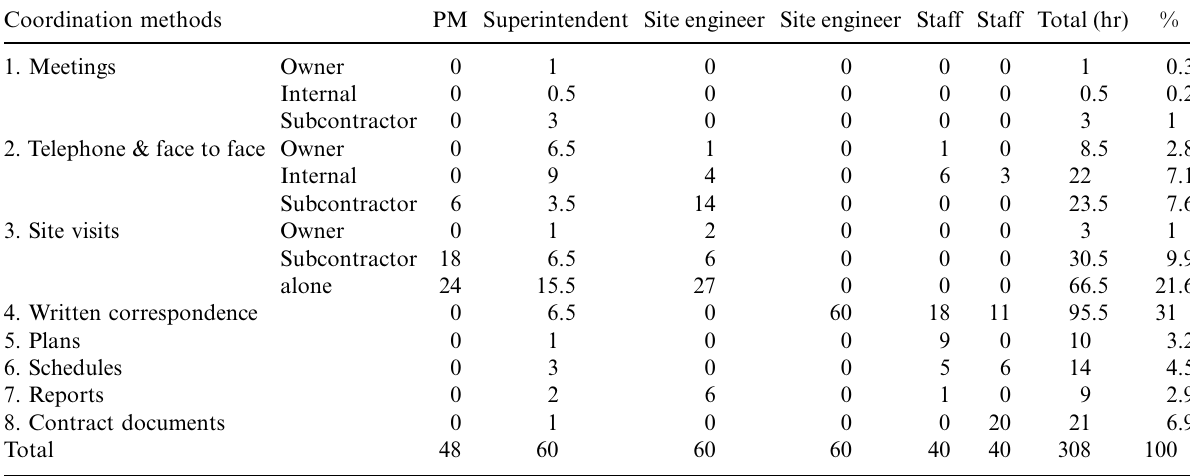
Table 5. Coordination time allocation of the case project Coordination methods